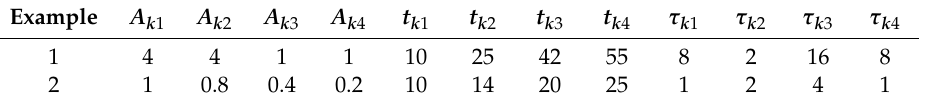
Table 1. Parameters of the signal E inc ( t ) with ν 1 = 0.8, ν 2 = 1.2, ν 3 = 1.4, ν 4 = 1.8.